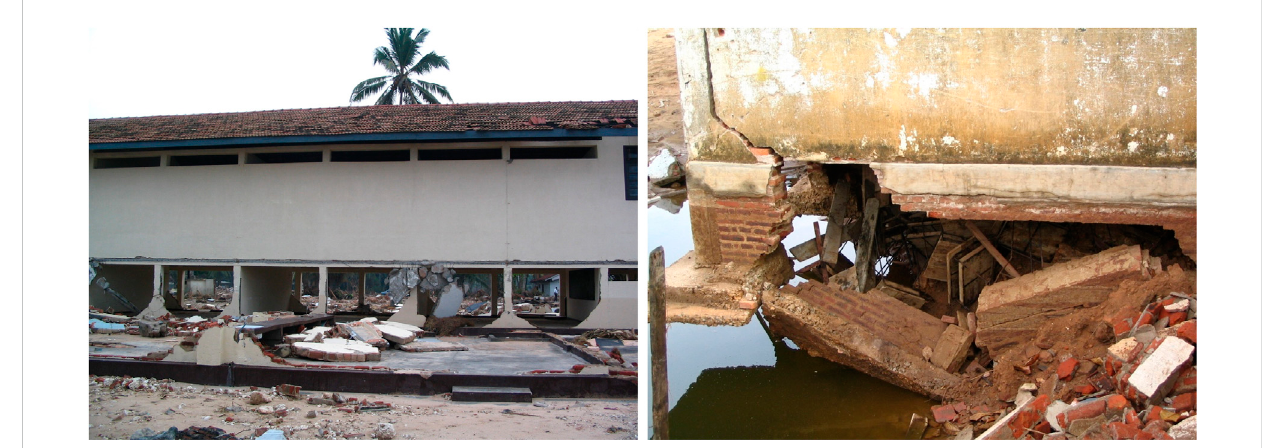
FIGURE 2 (A) Washed away building in front and washed away in fi lls at the rear. (B) Foundation scouring of a